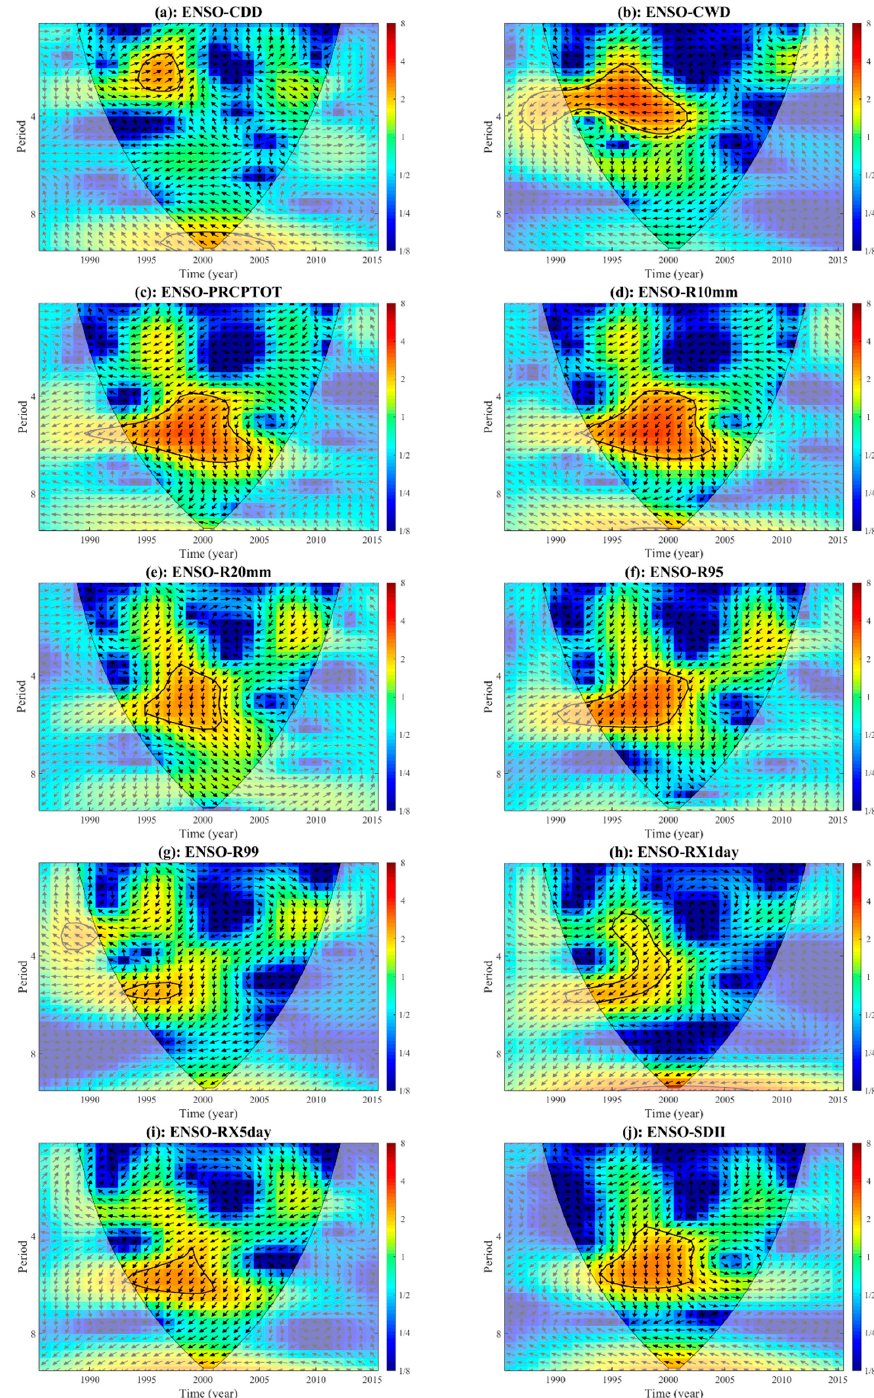
Figure 8. The crossover wavelet transforms between the ENSO and extreme precipitation indices across the Tibetan Plateau. Graphs represent ( a ) the relationship between CDD and ENSO event, ( b ) ENSO-CWD, ( c ) ENSO-PRCPTOT, (d) ENSO-R10mm, ( e ) ENSO-R20mm, ( f ) ENSO-R95, ( g ) ENSO-R99, ( h ) ENSO-RX1day, ( i ) ENSO-RX5day, and ( j ) ENSO-SDII. The thick black contour shows the 0.05 significance level of local power relative to yellow noise. The black line represents the cone of influence where edge influences might distort the picture, which is shown in lighter shades. The direction of the arrow indicates the relative phase relationship, with right-pointing arrows depicting that the two signals are in phase and left-pointing arrows indicating the anti-phase. The color bar on the right represents wavelet